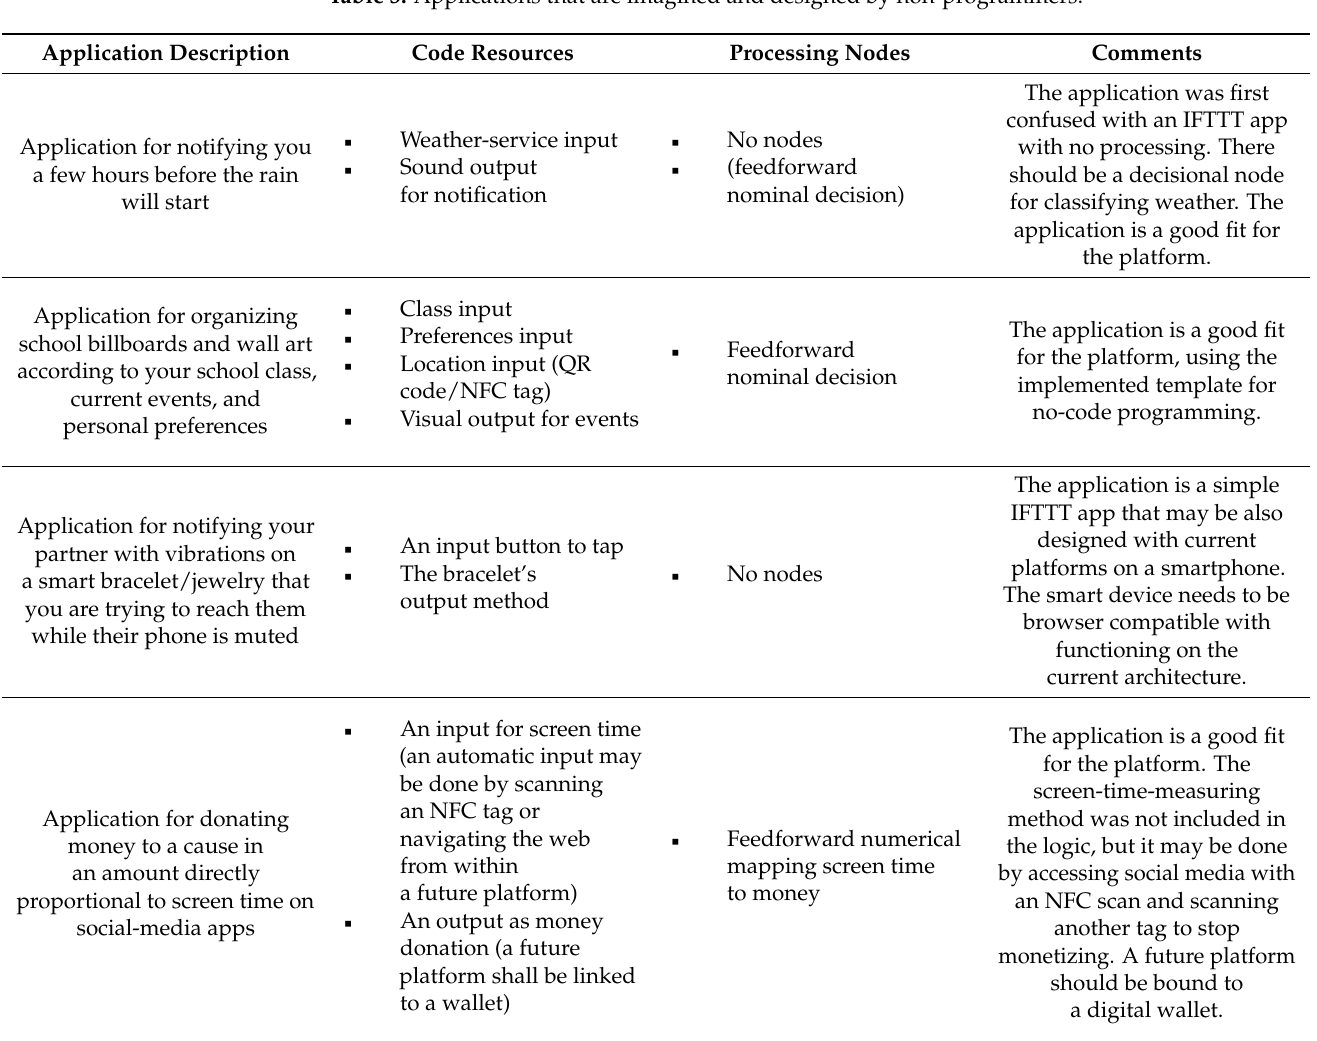
Table 3. Applications that are imagined and designed by non-programmers.